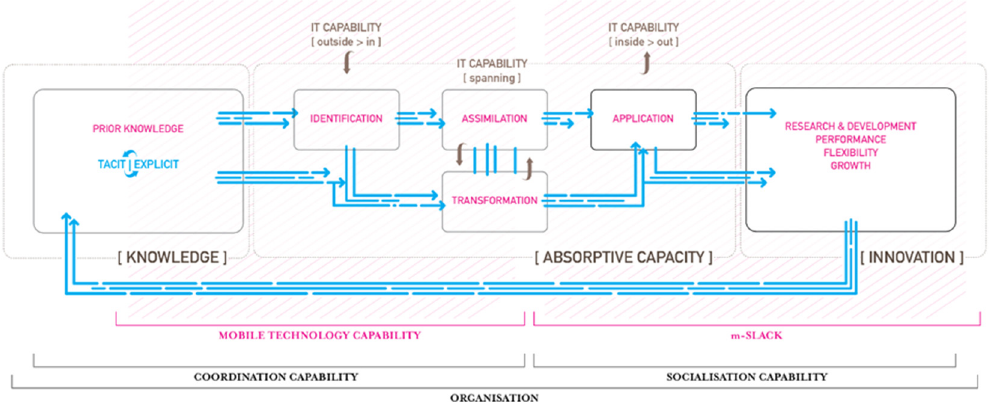
Figure 1. Mobile technology capability and m-slack .